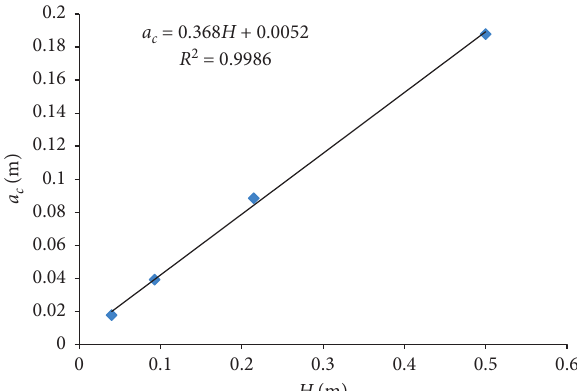
Figure 7: Critical effective crack length ac versus height H .